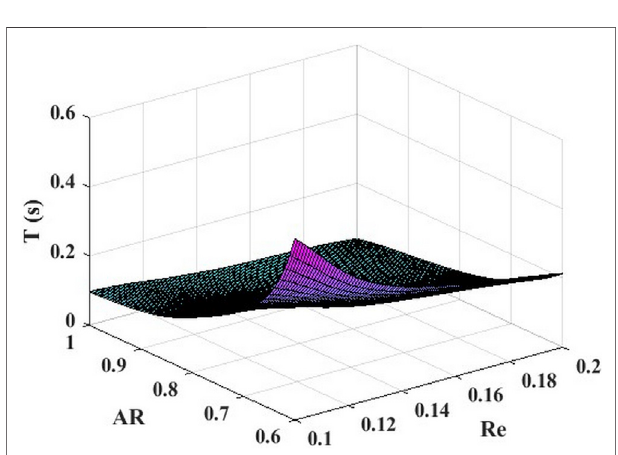
FIGURE 7 | Time-dependent leukocyte transmigration prediction model based on BP neural network.